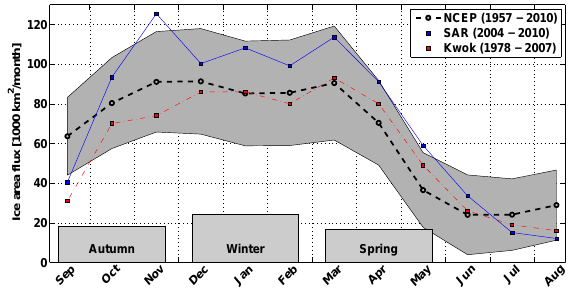
Fig. 3. Monthly mean Fram Strait sea ice area export during the year. Values from Kwok (2009) are added for comparison. Standard deviations of the NCEP values are shaded in grey. Increase due to the linear trend of each seasons ice export from 1957 to 2010 are plotted at the bottom.